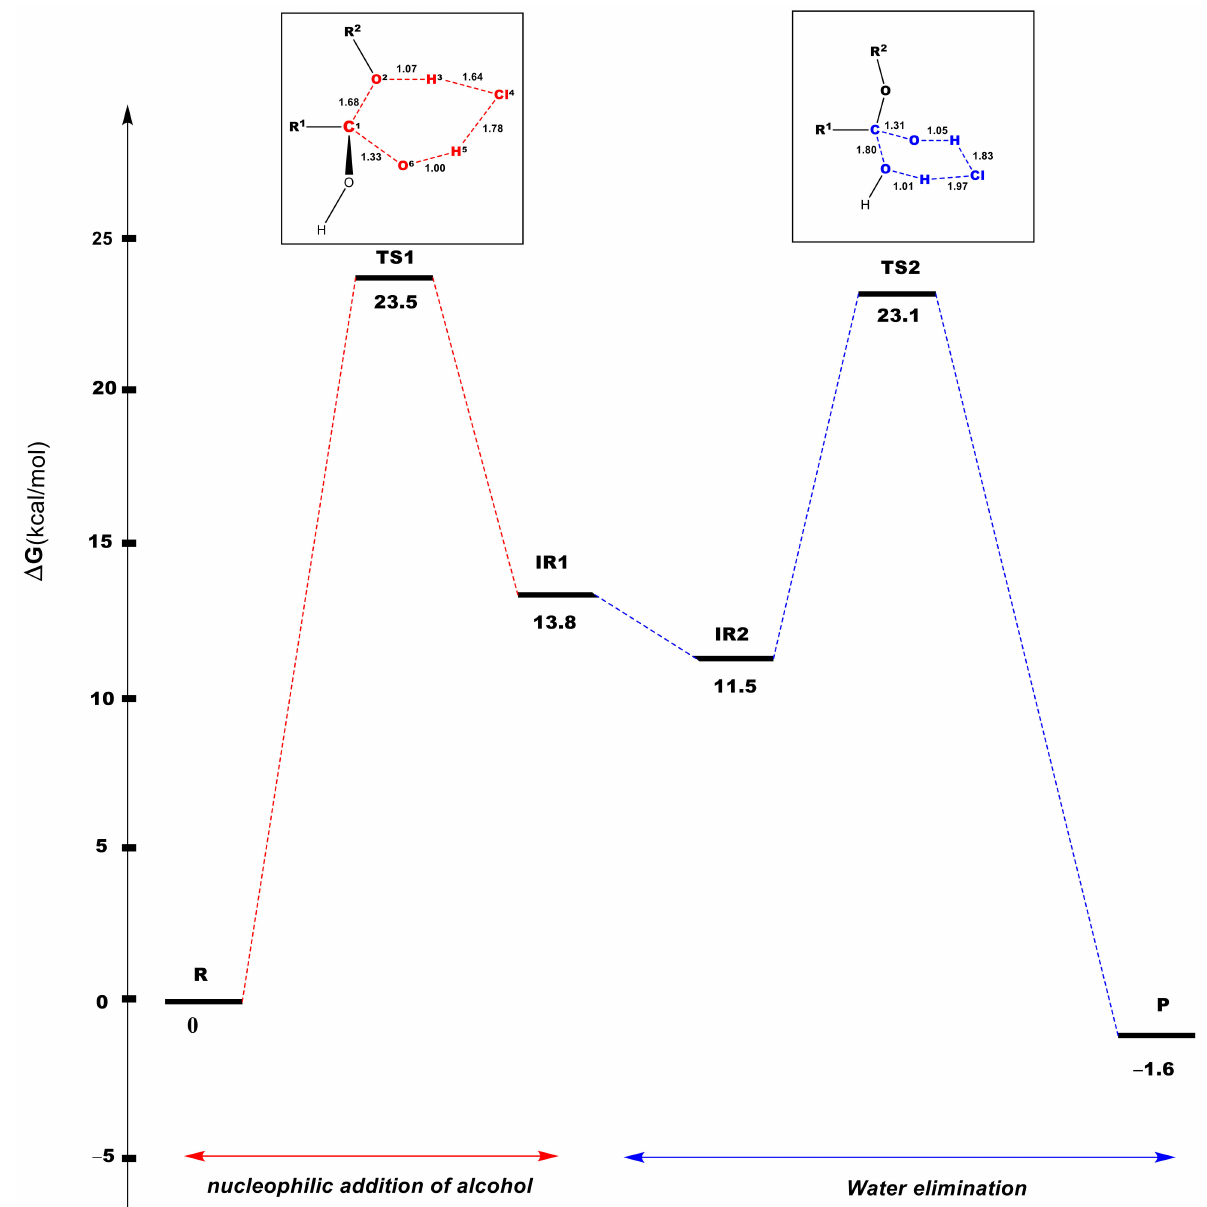
Figure 3. Computed reaction profile for betaine 2 , at the B3LYP/6-31+G(d,p)